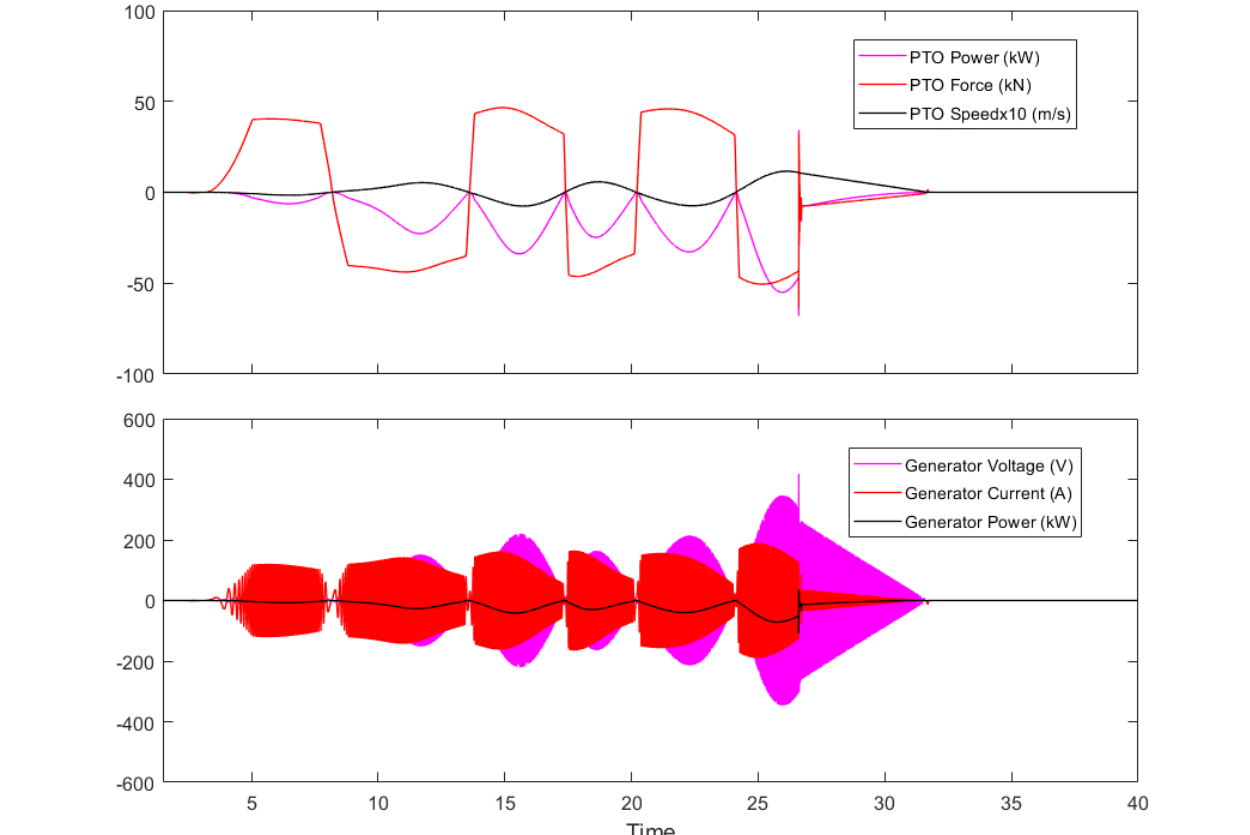
Fig. 9. Relevant mechanical (top) and electrical (bottom) signals of the actuating EMU using configuration 2 when a fault